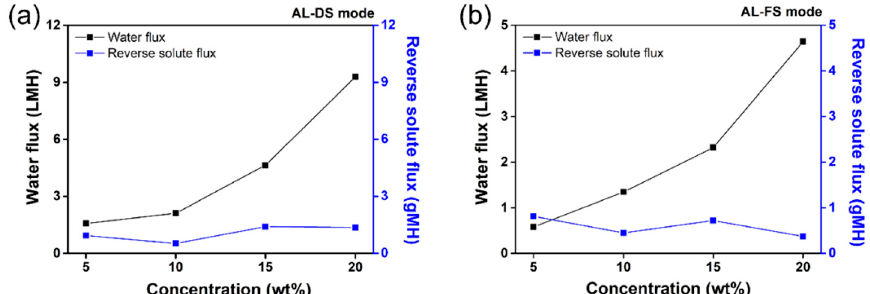
Figure 8. Water and reverse solute flux of tetrabutylphosphonium 2,4-dimethylbenzenesulfonate ([TBP][DMBS]) according to the concentration at room temperature in ( a ) AL-DS mode and ( b ) AL-FS mode.